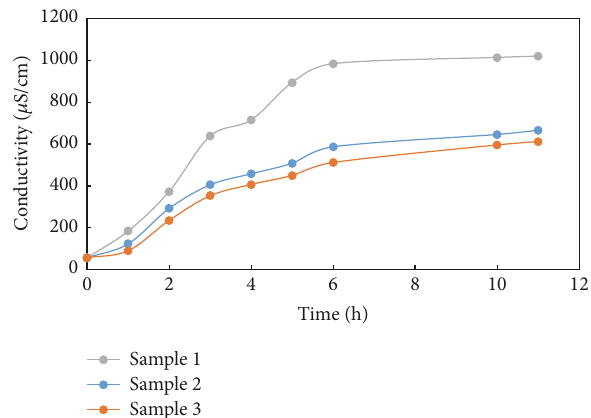
Figure 8: Conductivity changes for the different samples for Case 3.